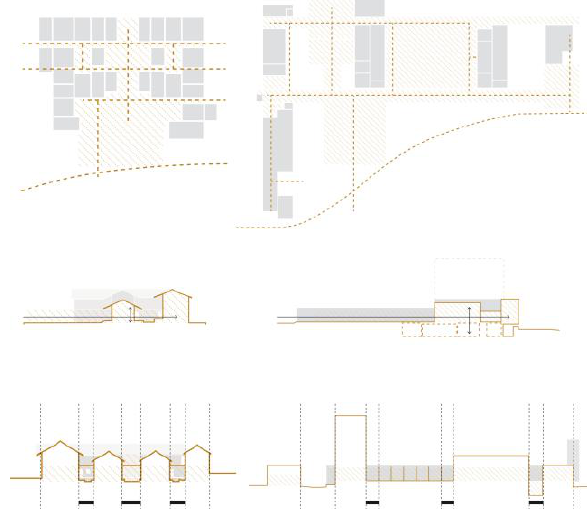
Figure 17. The architectural project for a new Research Center in Zhangyang Village reinterprets the spatial principles of the ancestral halls. Image by Seghezzi and Panta Bellido,